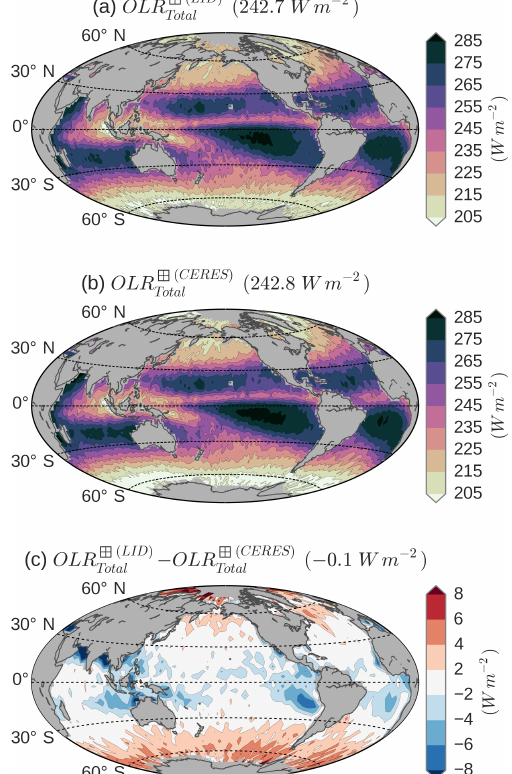
Figure 8. Zonal mean observations: (a) C (cid:1) (b) T opaque among opaque clouds and T (cid:1) (c) ε among thin clouds. Only nighttime conditions over ice-free thin oceans for the 2008–2015 period are considered. Shaded areas rep- resent the envelope (max to min) including interannual